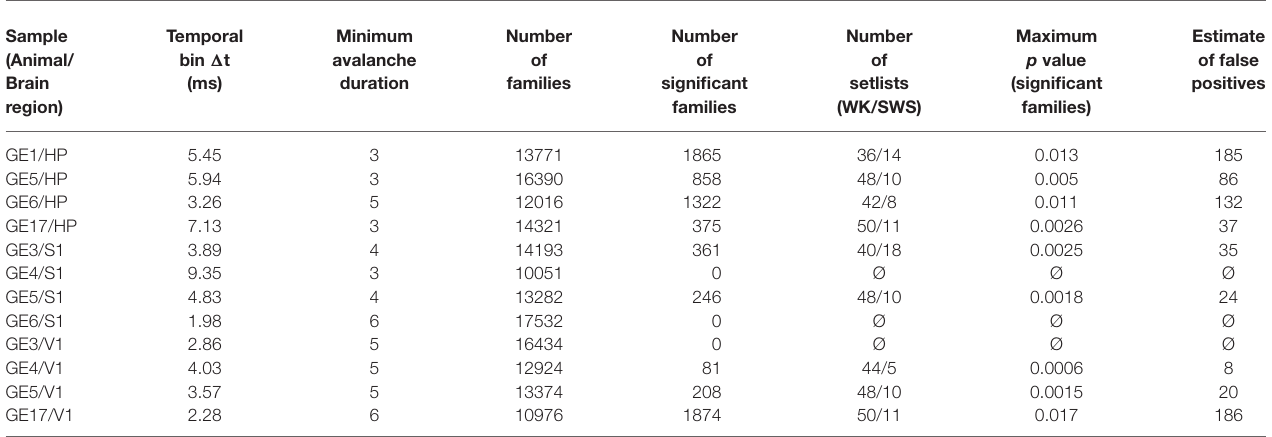
TABLE 1 | Avalanche and family data per sample.